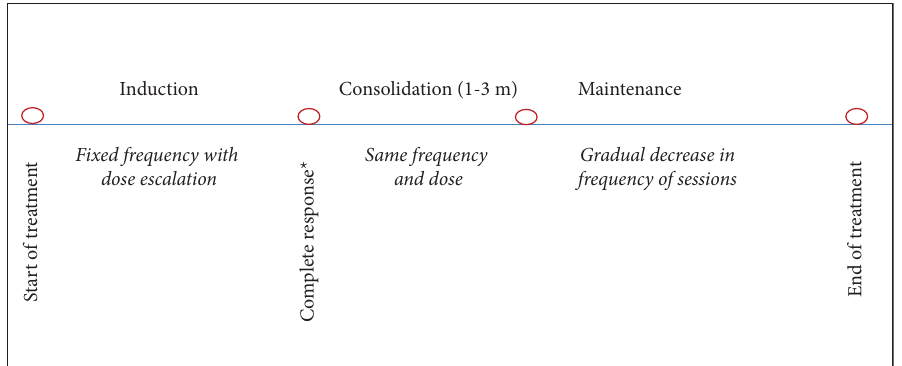
Figure 7: Maintenance regimen with phototherapy. Treatment of MF patients with phototherapy includes 3 phases: induction, con- solidation, and maintenance. Te dose of UV is escalated during the induction phase with fxation of the frequency of sessions, while both the dose and the frequency are fxed during the consolidation phase. During the maintenance phase, there is a gradual decrease of the frequency of the sessions with fxation of the dose [38]. ∗ Complete response is determined clinically, and has to be ≥ 4weeks; biopsy is only required when assessing postinfammatory hyperpigmentation or erythema versus the presence of residual lesion Supplementary Table 3: ISCL/EORTC revision to the staging of MF/SS (2007). Supplementary Table 4: search terms used in the literature review of the current study. Supplementary Table 5: details of OCEBM and identifcation of the level of evidence using OCEBM (2011). Supplementary Table 6: treatment recommendations for NB-UVB induction phase in patients with MF based on Fitzpatrick skin type. Sup- plementary Table 7: treatment recommendations for PUVA induction phase in patients with MF based on Fitzpatrick skin type. Supplementary Table 8: maintenance phase treatment of patients with MF with UV light (based on a thrice-weekly induction schedule for NB-UVB photo- therapy and at least twice weekly for PUVA phototherapy).